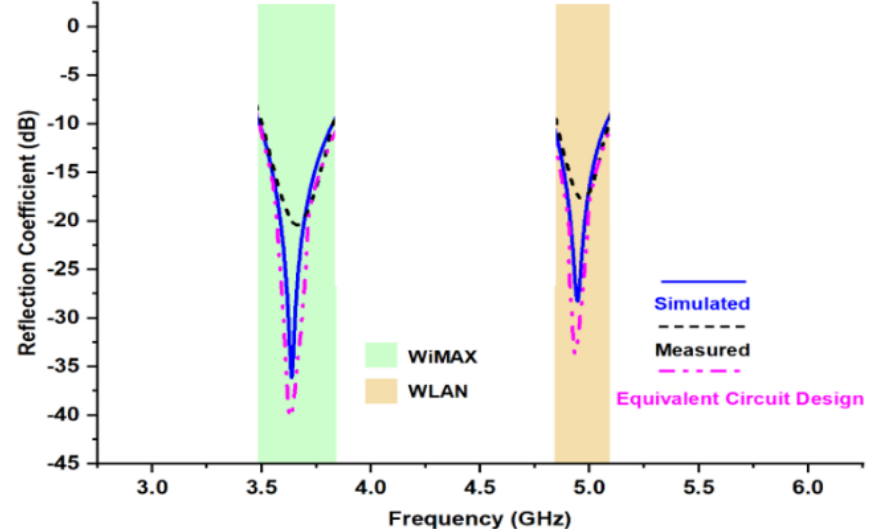
Figure 7. Comparison between simulated, measured, ECD reflection coefficient values.